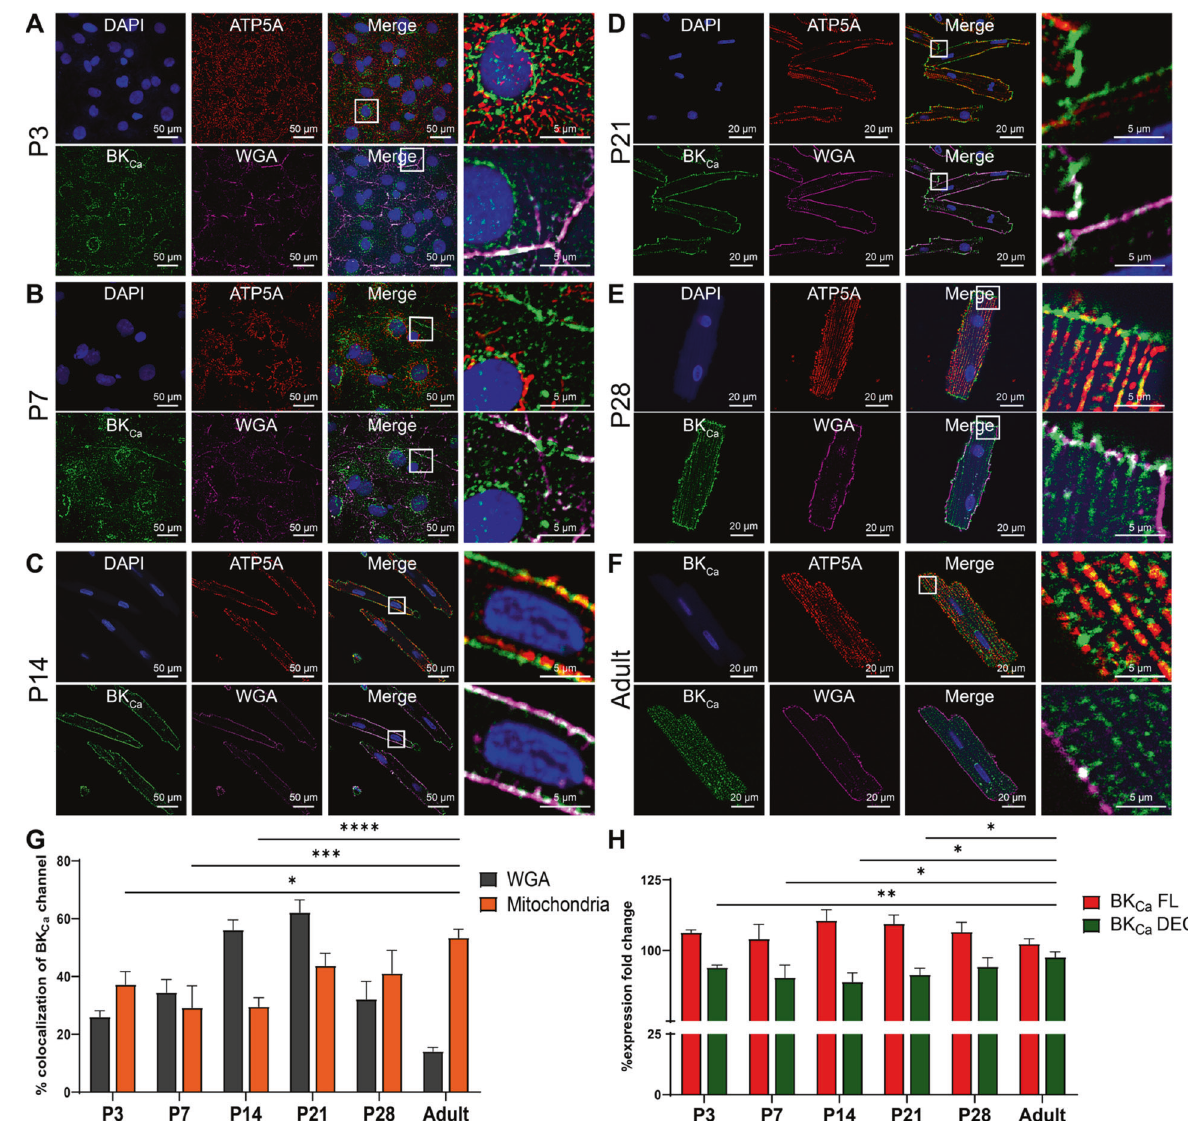
Fig. 3 Mitochondrial targeting BK DEC splicing increases with age in neonatal cardiomyocytes. A – F Cardiomyocytes isolated from aging (P3, P7, P14, P21, P28, and adult) rats loaded with WGA (magenta), fi xed, permeabilized, and labeled with BK Ca (green) and ATP5A (red). The nucleus was stained with DAPI (blue). The right panels of A – F show colocalization of merged images between BK Ca to WGA and BK Ca to ATP5A at higher magni fi cation. G Protein proximity index analysis showing percentage colocalization of BK Ca to WGA decreases, whereas BK Ca to mitochondria increases in cardiomyocytes isolated from P3 to the adult stage. H Relative levels of BK Ca FL and BK Ca DEC mRNA expression in cardiomyocytes isolated from P3, P7, P14, P21, P28, and adult hearts were measured by qRT-PCR and were normalized to their relative GAPDH expression. Data represented as fold-change to P3 BK Ca FL and P3 BK Ca DEC; mean ± SEM; at least three independent experiments. P -values were determined by a one-tailed paired student ’ s t -test; * ≤ 0.05, ** ≤ 0.001, *** ≤ 0.0001, **** ≤ 0.00001. reduced by 33 ± 3% after the addition of 100 nM IbTx (Fig. 4F). Thus, our results indicate that contrary to adults, in neonates, the activation of the BK Ca channel after IR injury is cardio-deleterious tease out the role of plasma membrane BK Ca channels in HR- whereas BK Ca channel inhibition is cardioprotective. induced apoptosis in NCMs (P3). IbTx showed comparable apoptotic positive nuclei 21 ± 8% after HR injury to dimethyl sulfoxide (DMSO) control 30 ± 9% as indicated by TUNEL assay (Fig. 5A, B and quanti fi ed in D). Surprisingly, NS1619 treatment showed 63 ± 14% TUNEL-positive cells as compared to DMSO control 30 ± 8% after HR injury (Fig. 5A, C, D). We have earlier shown that gain of function transgenic adult mice presented cardioprotection after ischemic preconditioning as well as after IR injury [22]. Here we isolated NCMs from wild type and Tg-BK CaR207Q mice [9] and subjected P3 NCMs to HR injury. After hypoxia and reoxygenation, we discovered that NCMs Cell Death Discovery (2022)